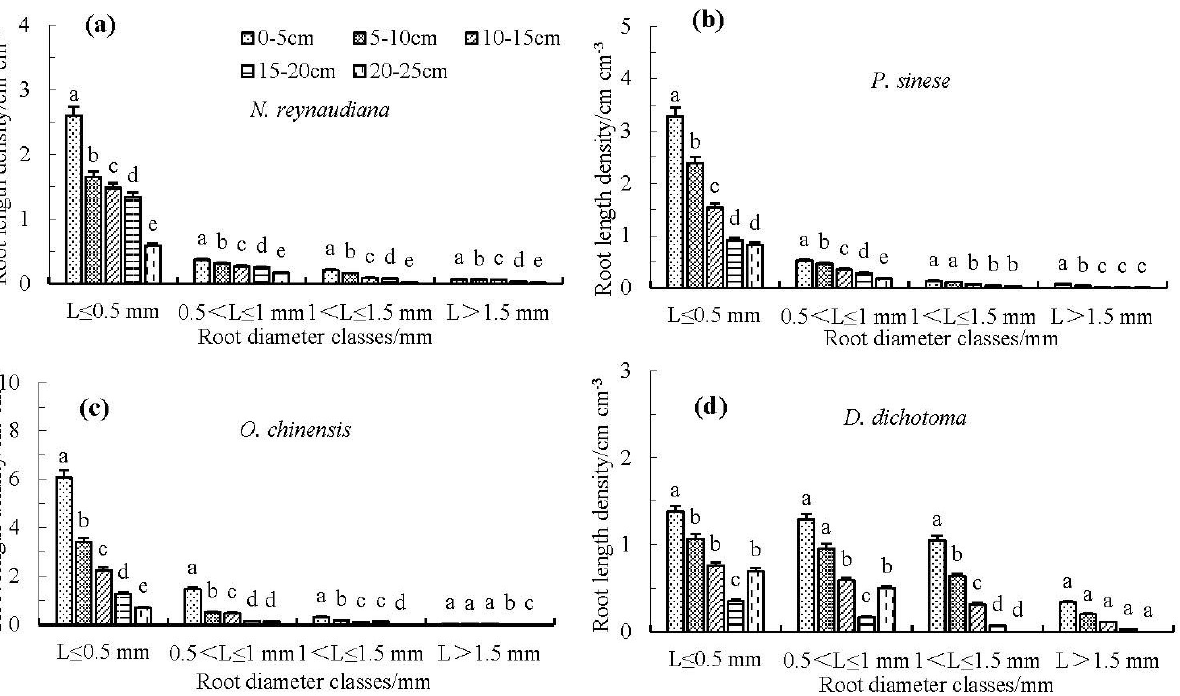
Figure 6. Comparison of root length density with different root diameter classes of Neyraudia reynau-